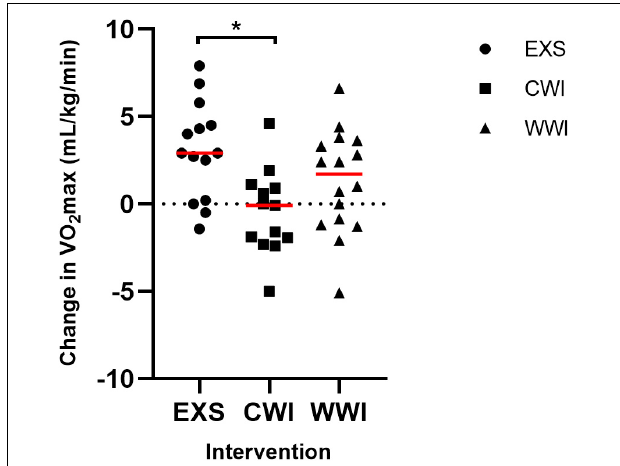
FIGURE 4 | Change in cardiorespiratory fitness ( ˙ VO 2 max [mL/kg/min]) following 12 sessions of Exercise [EXS ( n = 14)], post-exercise Cold Water Immersion [CWI ( n = 14)] and post-exercise Warm Water Immersion [WWI ( n = 16)]. *Indicates significant difference between EXS and CWI ( post hoc , p = 0.002), following significant interaction ( p = 0.004).